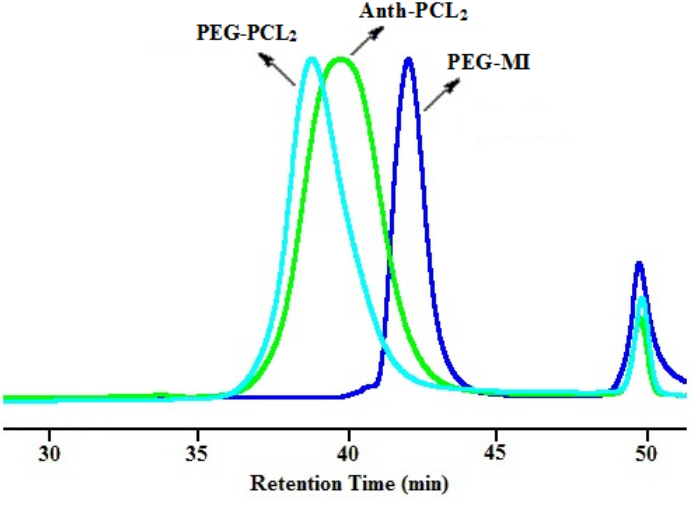
Figure 8. GPC overlay of linear PEG-MI, anth-(PCL) PEG–(PCL) block copolymer in THF at 30 °C. 2